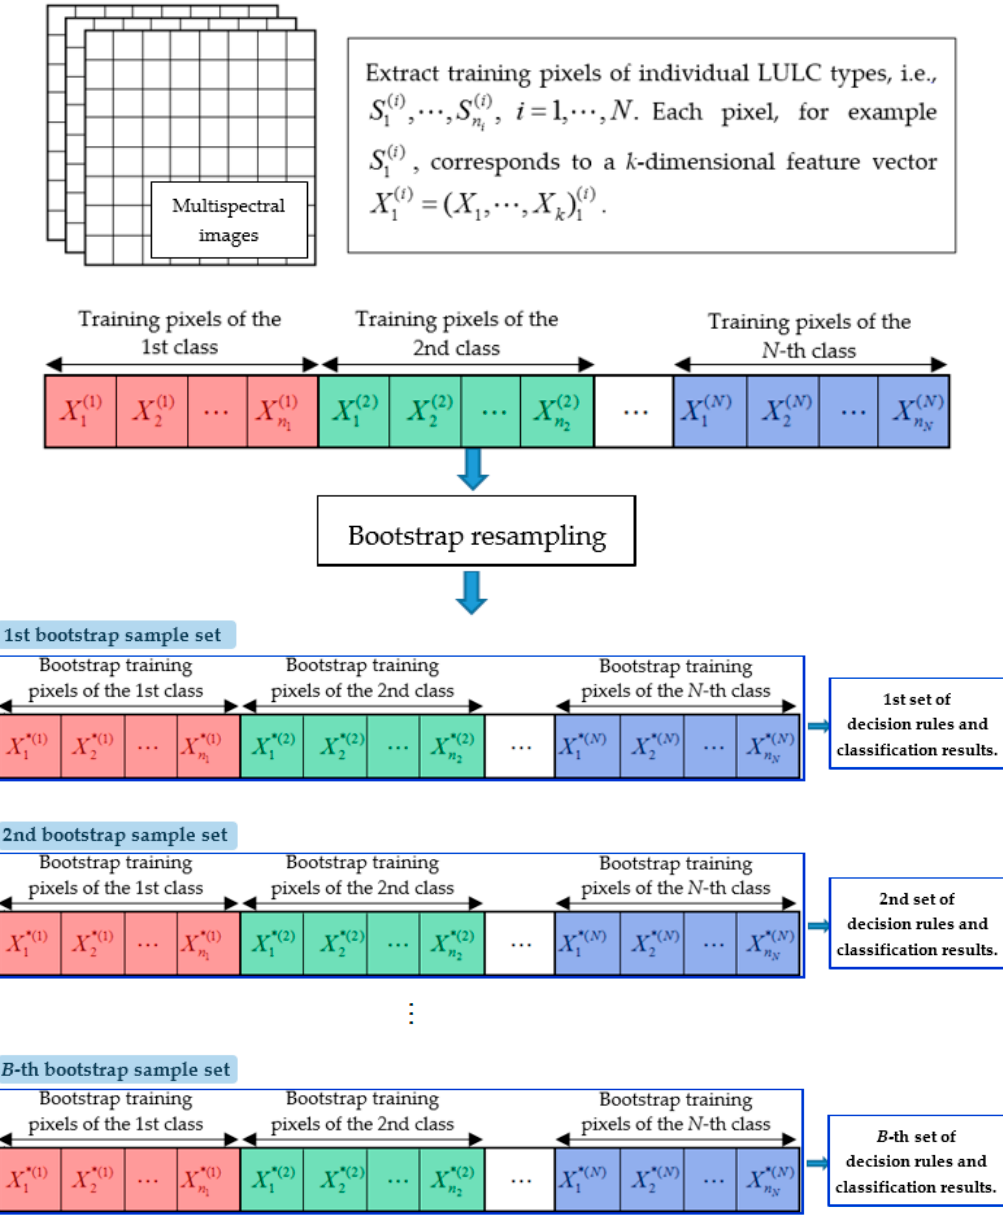
Figure 5. Schematic of bootstrap resampling of the training samples and its application to multispectral and multiclass LULC classification.